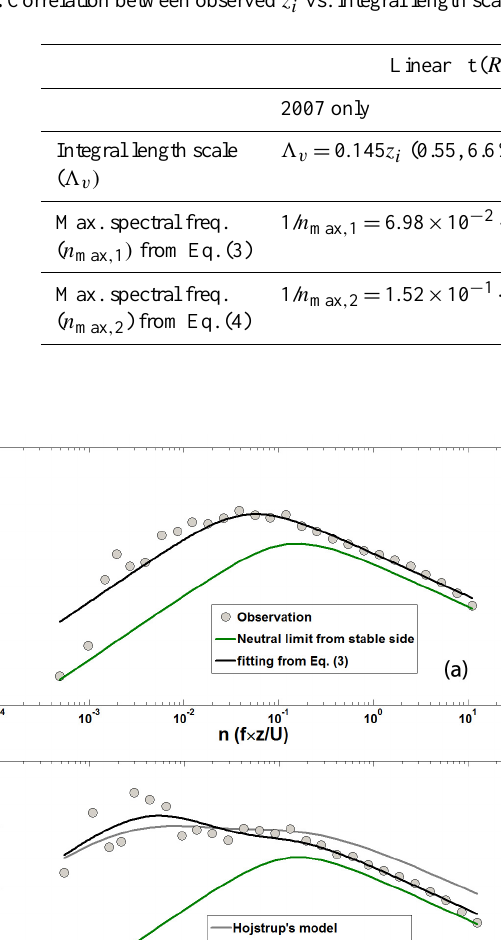
Table 2. Correlation between observed z i vs. integral length scale and normalized maximal spectral frequency.